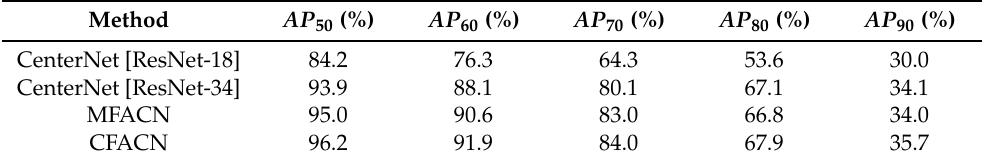
Table 2. The detection performance of CenterNet using ResNet-18 or ResNet-34 as its backbone, the proposed MFACN method using ResNet-18 as its backbone, and the proposed CFACN method using ResNet-18 as its backbone, in terms of different intersection over union (IoU) values.